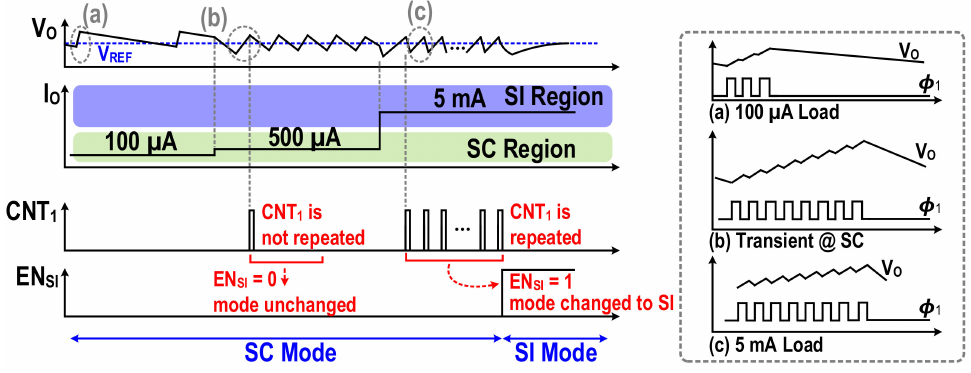
Figure 5. Digital counter method for the load current transition cases in µ -SCC